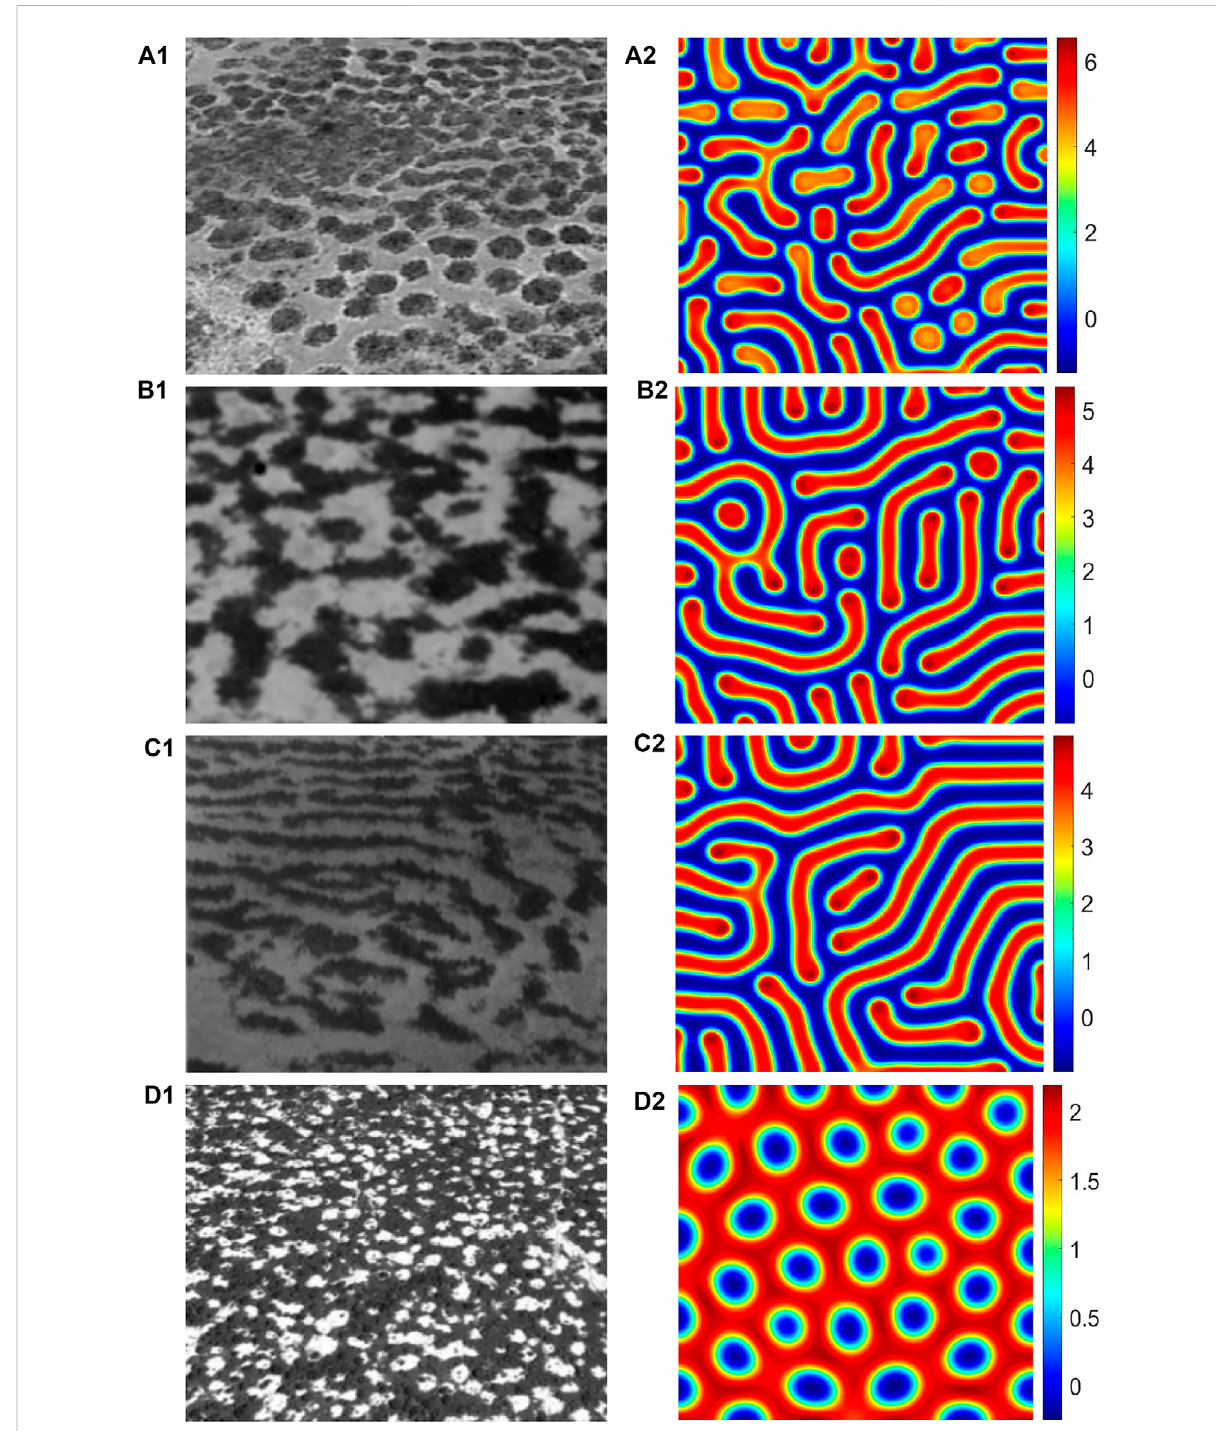
FIGURE 7 Vegetation structure observed in the nature and pattern structure obtained by numerical simulation. Fig ( a 1 - d 1 ) shows realistic vegetation pattern structures: (